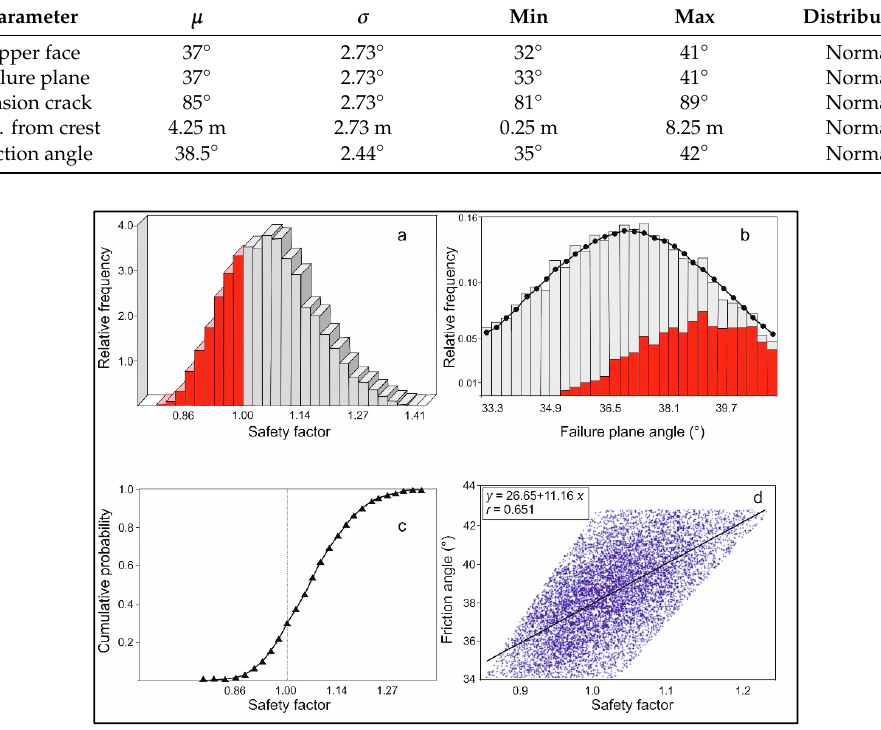
Figure 7. Results of the probabilistic analysis for planar failure affecting individual blocks. Key: ( a ) histogram representing the distribution of safety factor, for all valid blocks generated by the Monte Carlo (MC) method. The red bars represent blocks with SF less than 1.00; ( b ) distribution of failed blocks (red bars) vs. the variation of the failure plane angle; ( c ) cumulative safety factor distribution giving the probability value that SF will be less than or equal to the value of the variable at that point; ( d ) relationship between friction angle and SF. Number of simulations = 10,000.